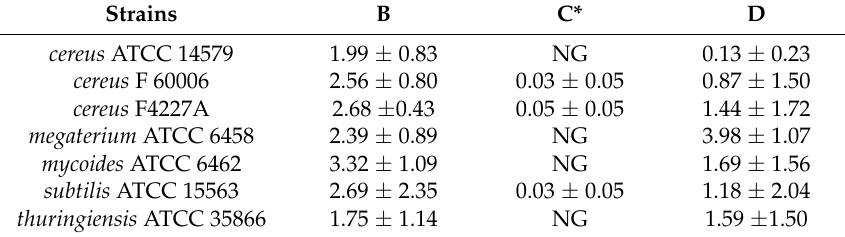
Table 3. Detection of Bacillus strains in log CFU/g after exposure to non-neutralized eye cream products.